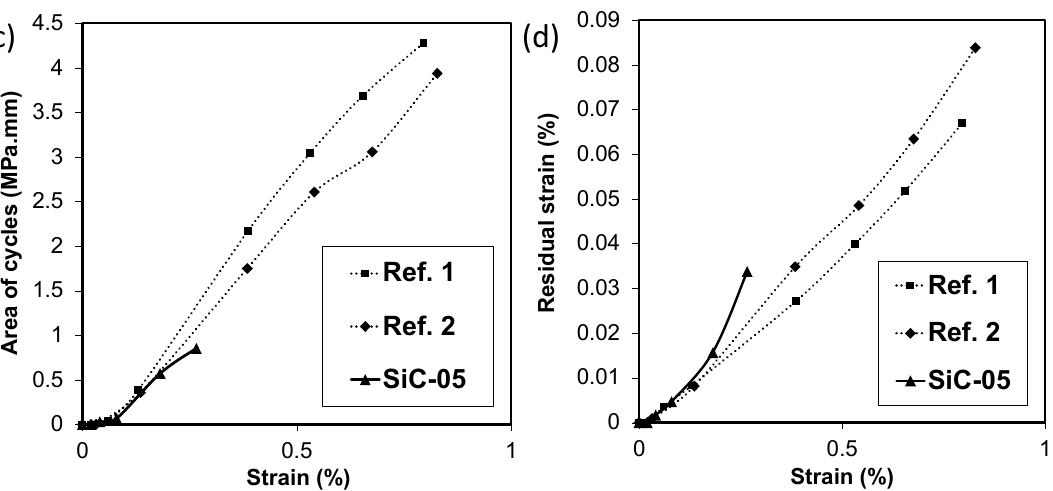
Figure 13. Reduced modulus ( a ), Full width at half-maximum ( b ), Area of the cycles ( c ), and Residual strains after unloading ( d ) as a function of the strain before unloading for reference materials (Ref. 1 and Ref. 2) and SiC-05.